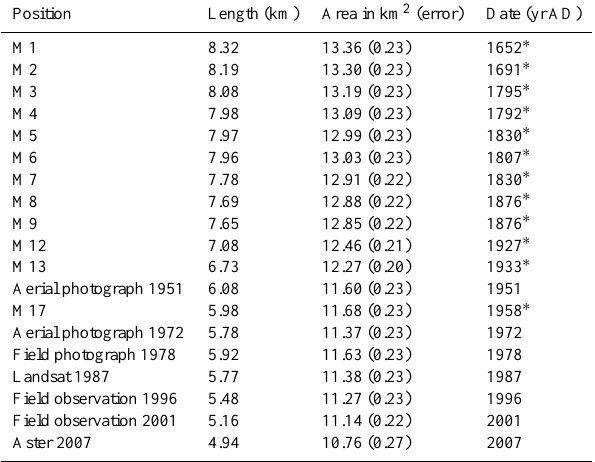
Table 2. Length and area reconstructions for Glaciar Esperanza Norte. Length measurements have a constant 60-m error (two Land- sat pixels), whereas areal measurements have a variable error based on the perimeter of the glacier and the spatial resolution of the ma- terial used in each